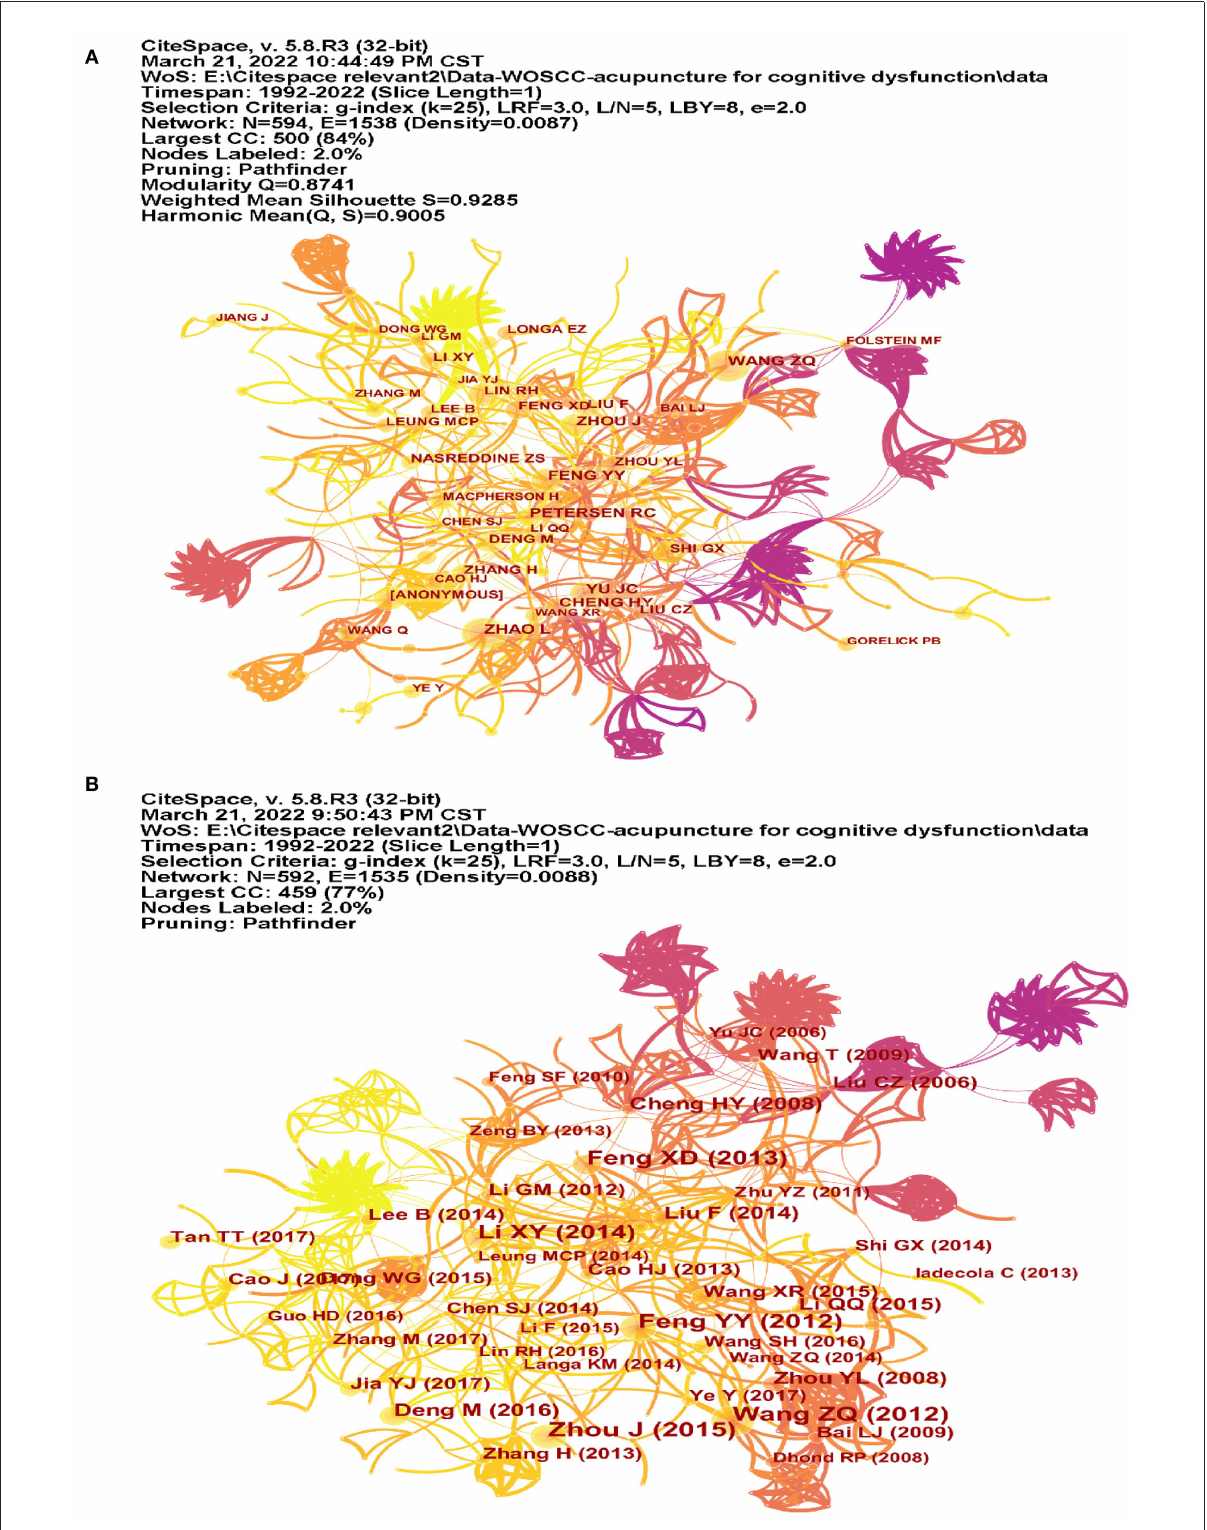
FIGURE7 The co-citation map of authors and references. (A) The co-citation map of authors and (B) the co-citation map of authors